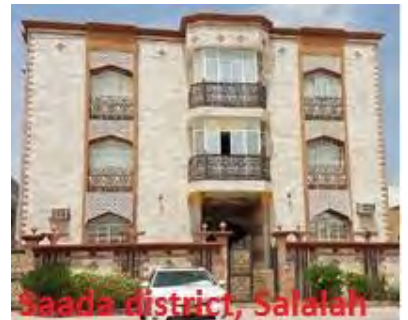
Figure 20. Fac¸ade’s photograph building location